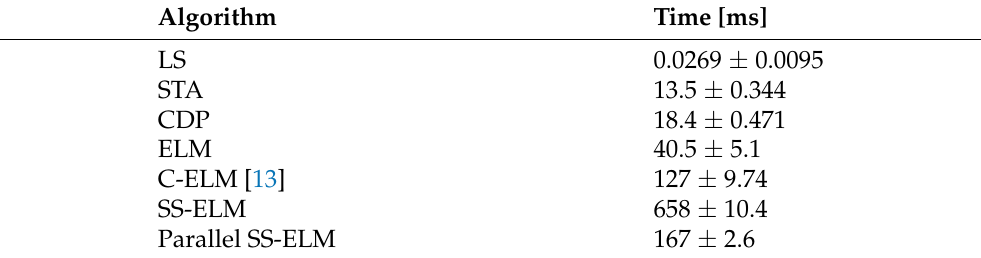
Table 4. Algorithm execution